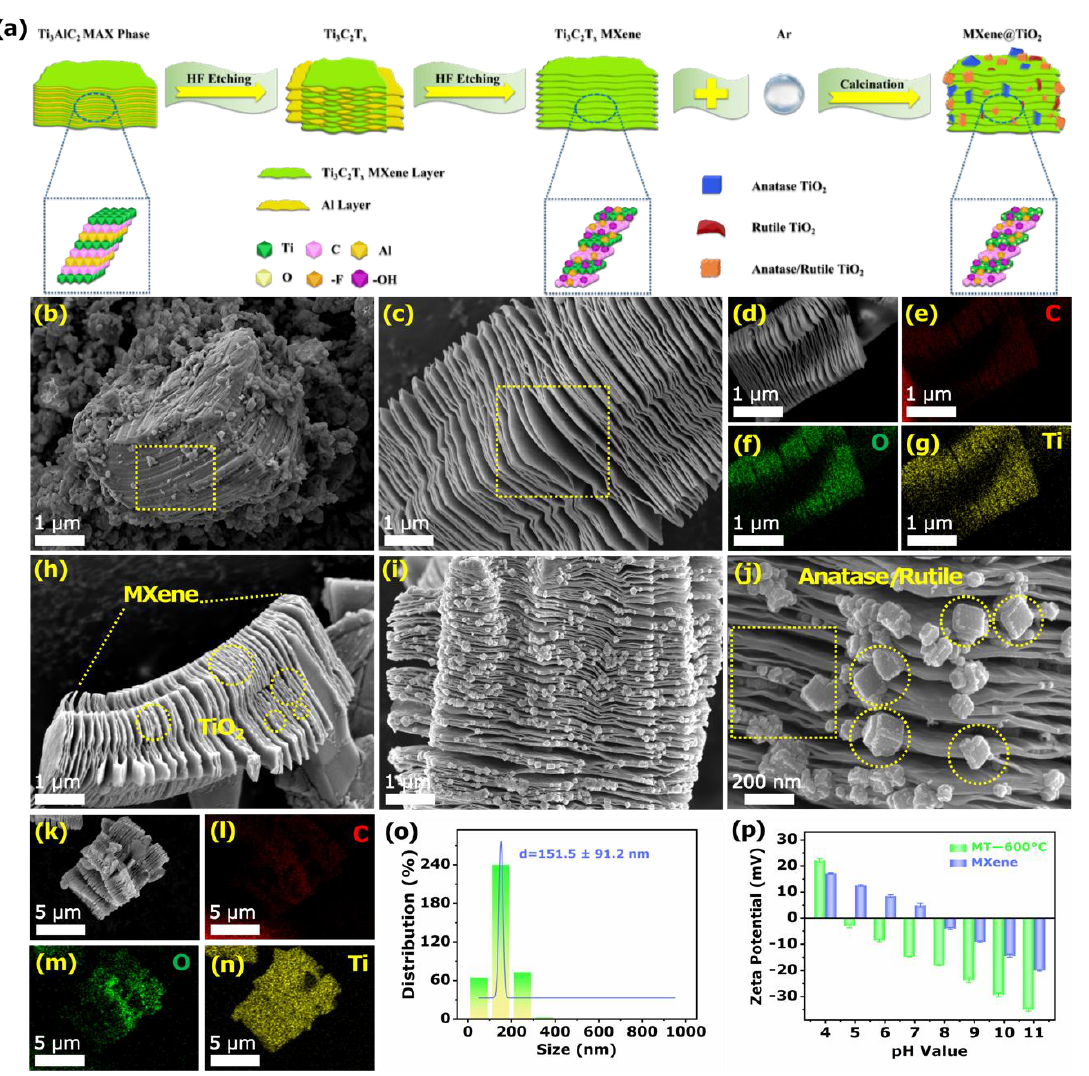
Figure 1. ( a ) Schematic illustration of the synthesis of MXene@TiO 2 composites. SEM images of ( b ) Ti 3 AlC 2 , ( c – d ) MXene, and mappings of ( e ) C, ( f ) O, and ( g ) Ti elements. SEM images of ( h – k ) MT - 600 °C, under different angles and mappings of ( l ) C, ( m ) O, and ( n ) Ti elements. ( o ) Particle size distribution histogram. ( p ) Zeta potential of MXene and MT -600°C with different pH value.